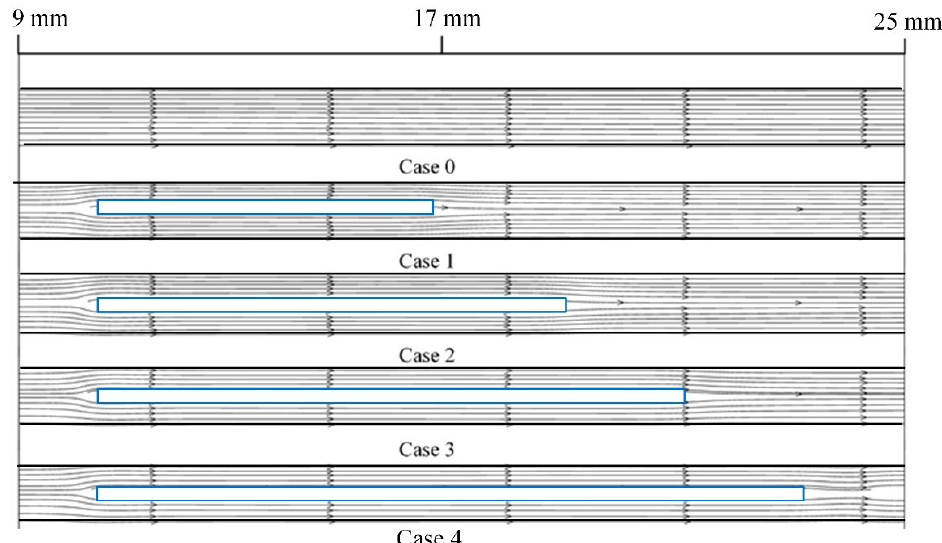
Figure 6. Streamline diagram of Case 0–4 at the inlet velocity of 1.5 m/s.